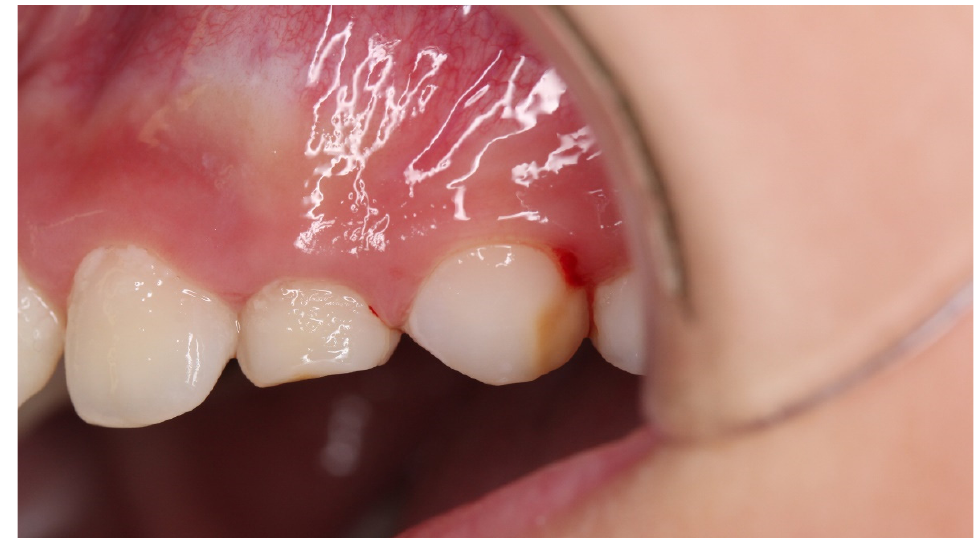
Figure 8. Case 3: intraoral photograph before treatment.